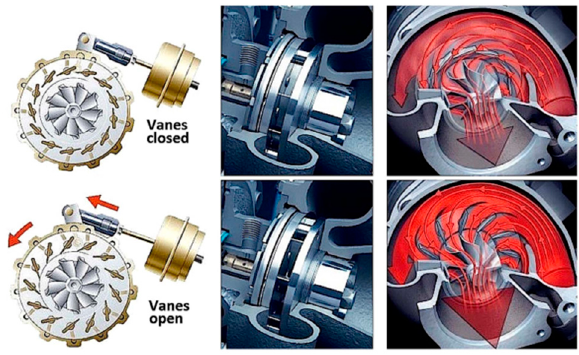
Figure 1. Variable geometry turbocharger (VGT) operating principle [7].